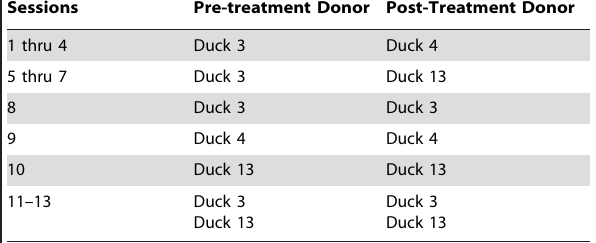
Table 2. Training session stimuli.